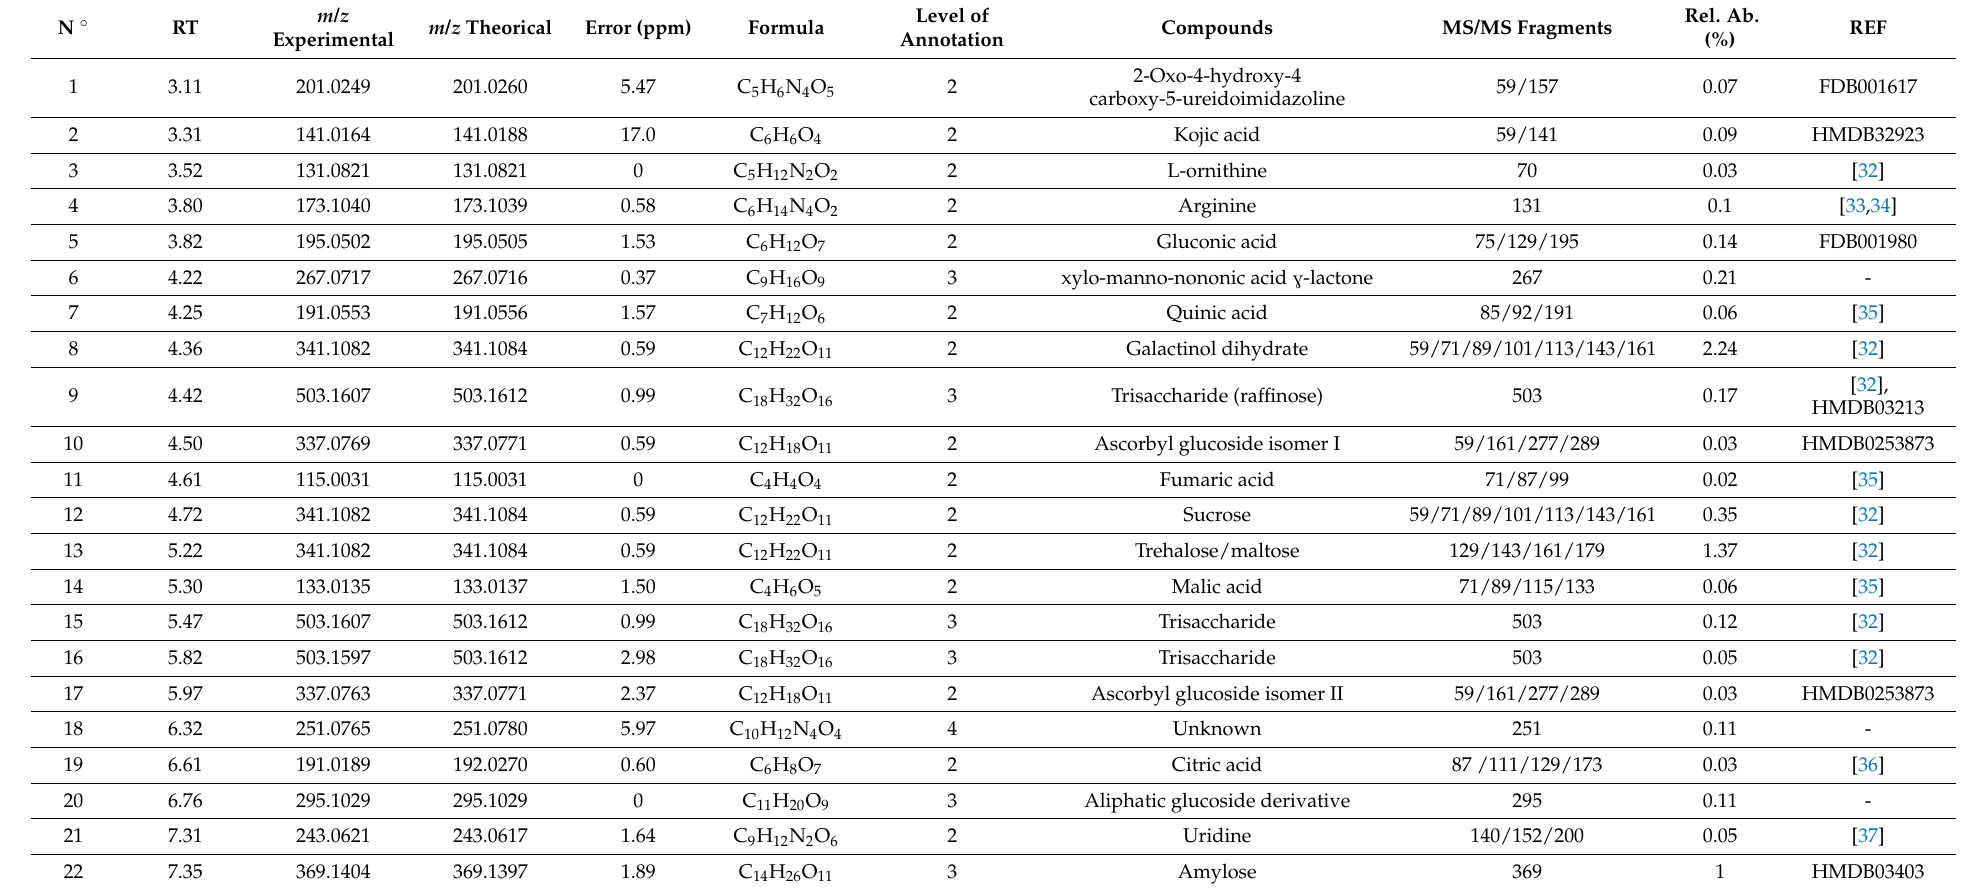
Table 1. The metabolite profiling of the ethanolic extract of C. esculentus L. rhizomes as analyzed by